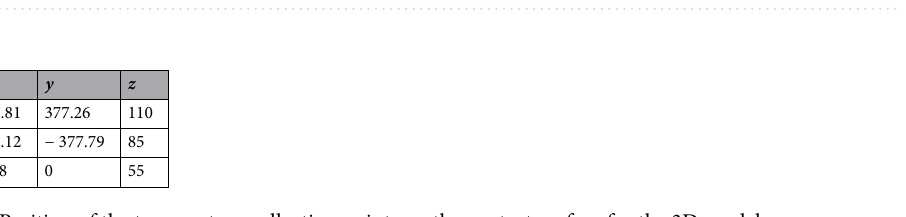
Table 11. Position of the temperature collection points on the contact surface for the 3D